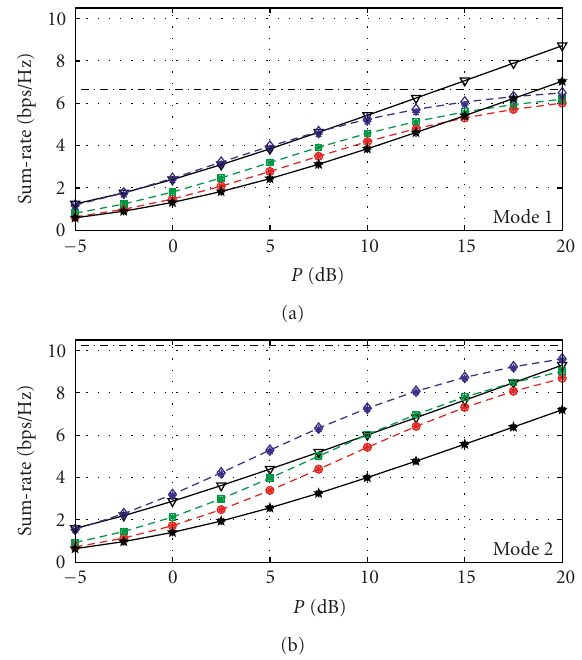
Figure 4: Virtual MIMO system sum-rate for two-antenna mode 1 ( K = 16) and mode 2 ( K = 64) in the presence of Rayleigh fading, constant Tx power, and channel norm CQI. Solid curves with stars (“ (cid:3) ”) refer to TDMA-RR, while solid lines with triangles (“ (cid:5) ”) correspond to TDMA-BUS. Dashed curves with circles (“ ◦ ”), dashed curves with squares (“ (cid:6) ”) and dashed curves with diamonds (“ (cid:14) ”) refer to pure ORR (ZFBF-PF throughput lower bound), ORR-Norm and ZFBF-SUS (ZFBF-PF throughput upper bound), respectively. Dash-dotted curves represent the asymptotic upper bound presented in (22). In all cases, point values (“ ∗ ”) were simulated to verify the analytical